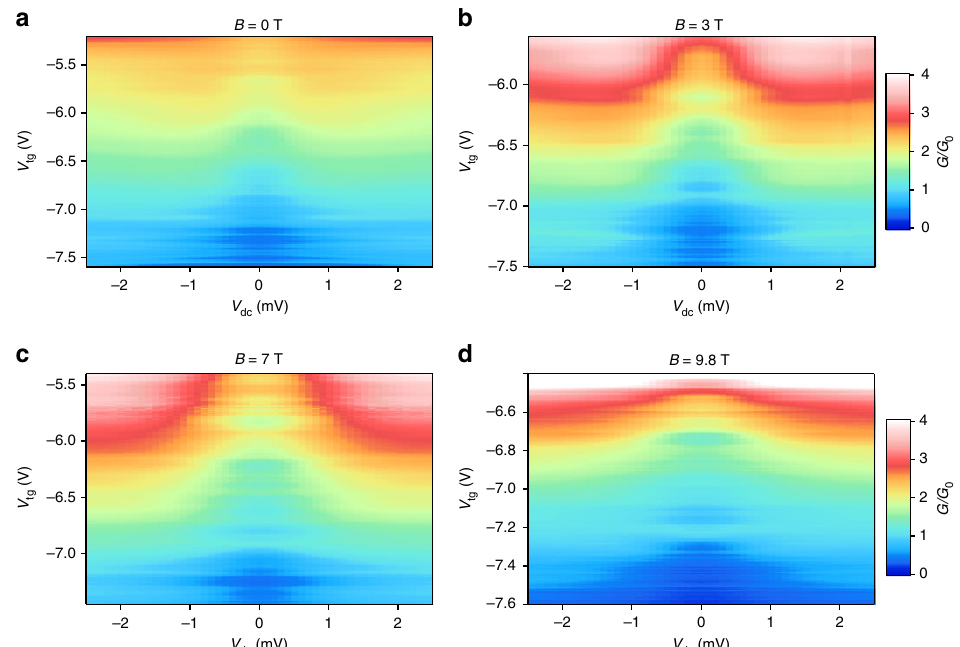
Fig. 4 Color maps of the differential conductance G as a function of the applied offset V dc and the split-gate voltage at different magnetic fi elds. a V tg was lowered by 20 mV between successive V dc sweeps from − 5.2 to − 7.6 V, B = 0 T. b V tg was decreased by 15 mV between successive V dc sweeps from − 5.6 to − 7.5 V. A magnetic fi eld of B = 3 T was applied perpendicularly to the 2DEG. c V tg was lowered by 15 mV for successive V dc sweeps from − 5.5 to − 7.45 V. A magnetic fi eld of B = 7 T was applied perpendicularly to the 2DEG. d V tg was decreased by 9 mV between successive V dc sweeps from − 6.55 to − 7.6 V. A magnetic fi eld of B = 9.8 T was applied perpendicularly to the